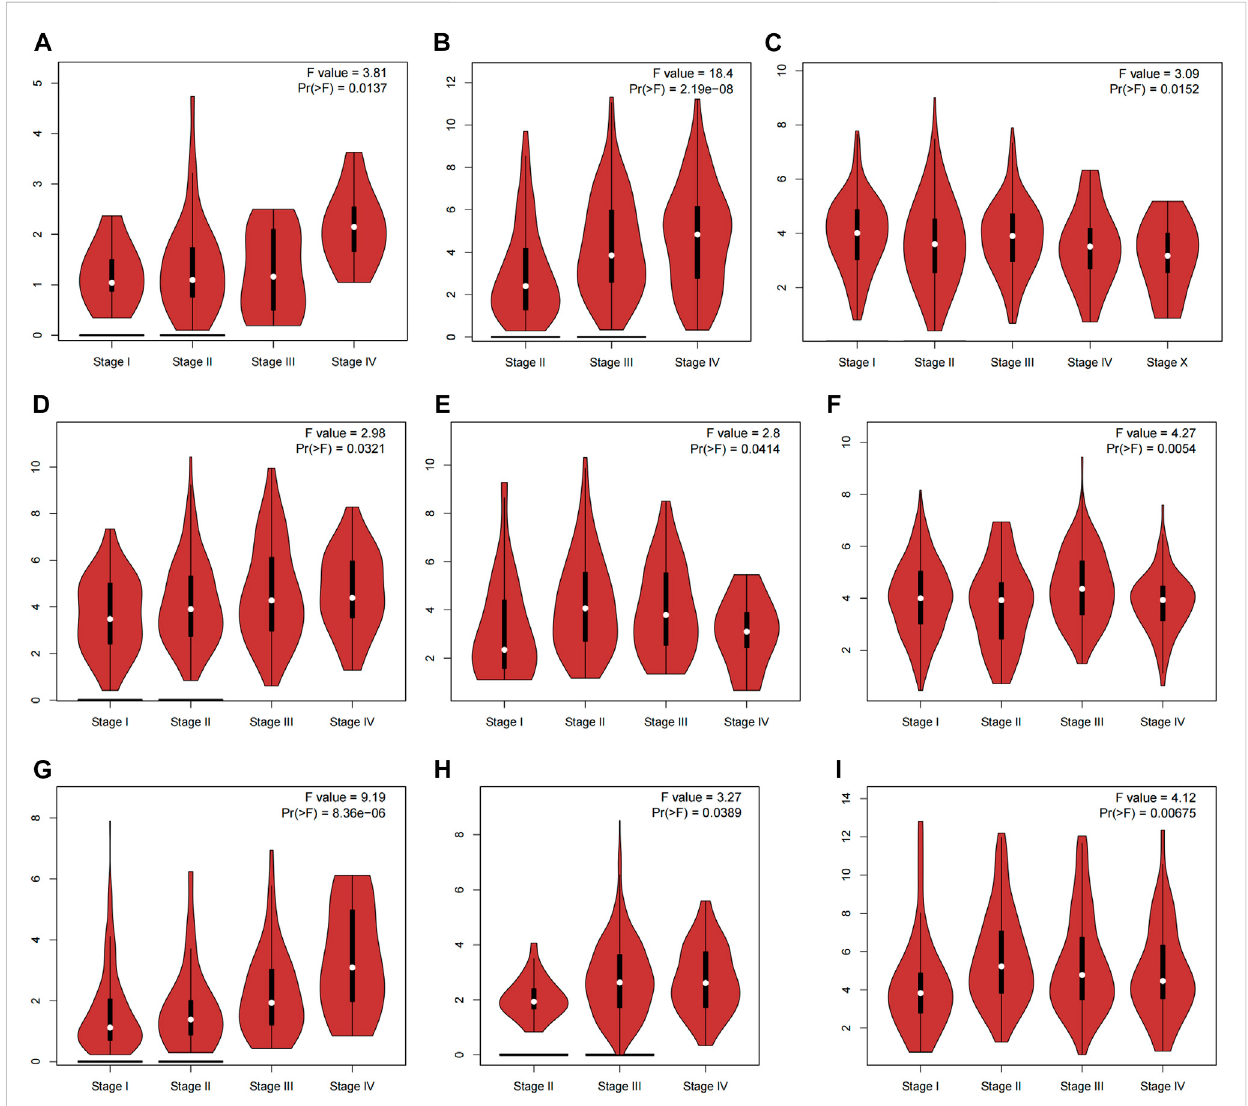
FIGURE 2 Analysis of CNN1 expression in different tumor stages based on the GEPIA database. (A) ACC, (B) BLCA, (C) BRCA, (D) COAD, (E) ESCA, (F) KIRC, (G) KIRP, (H) OV, and (I) STAD.